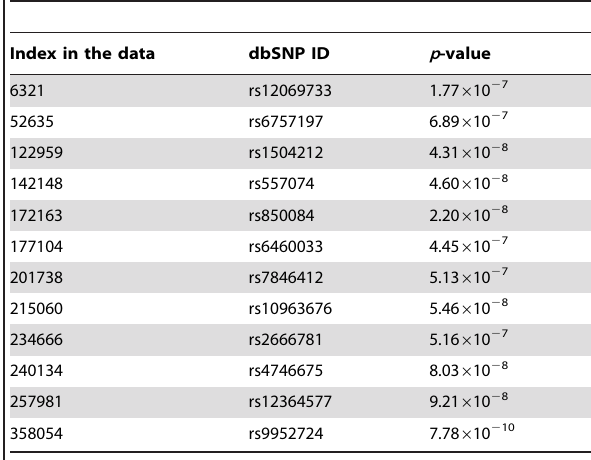
Table 2. Odds ratios for rs3743175 in SCAPER and rs1394608 in SGCD .